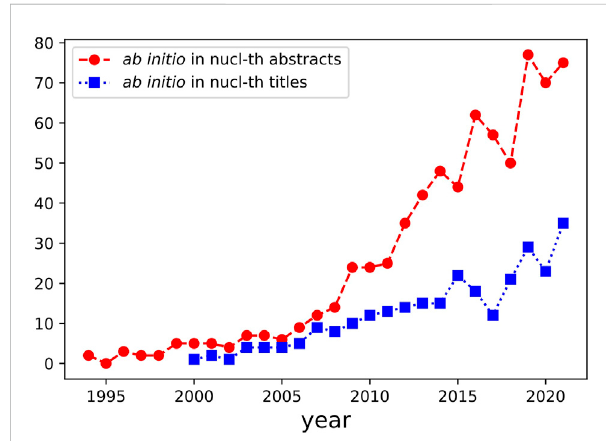
Number of times the term ab initio appears in the abstract (red circles) and titles (blue squares) of papers on arXiv:nucl-th in a given